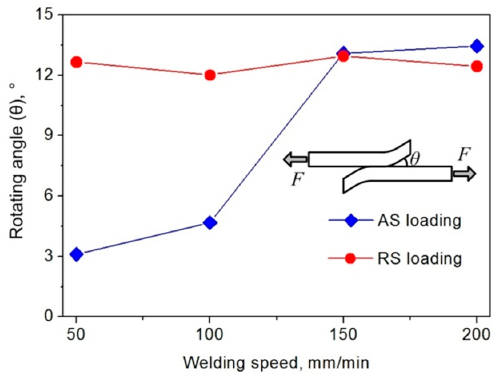
Figure 9. Rotating angle of the lap sheets during the lap shear test.